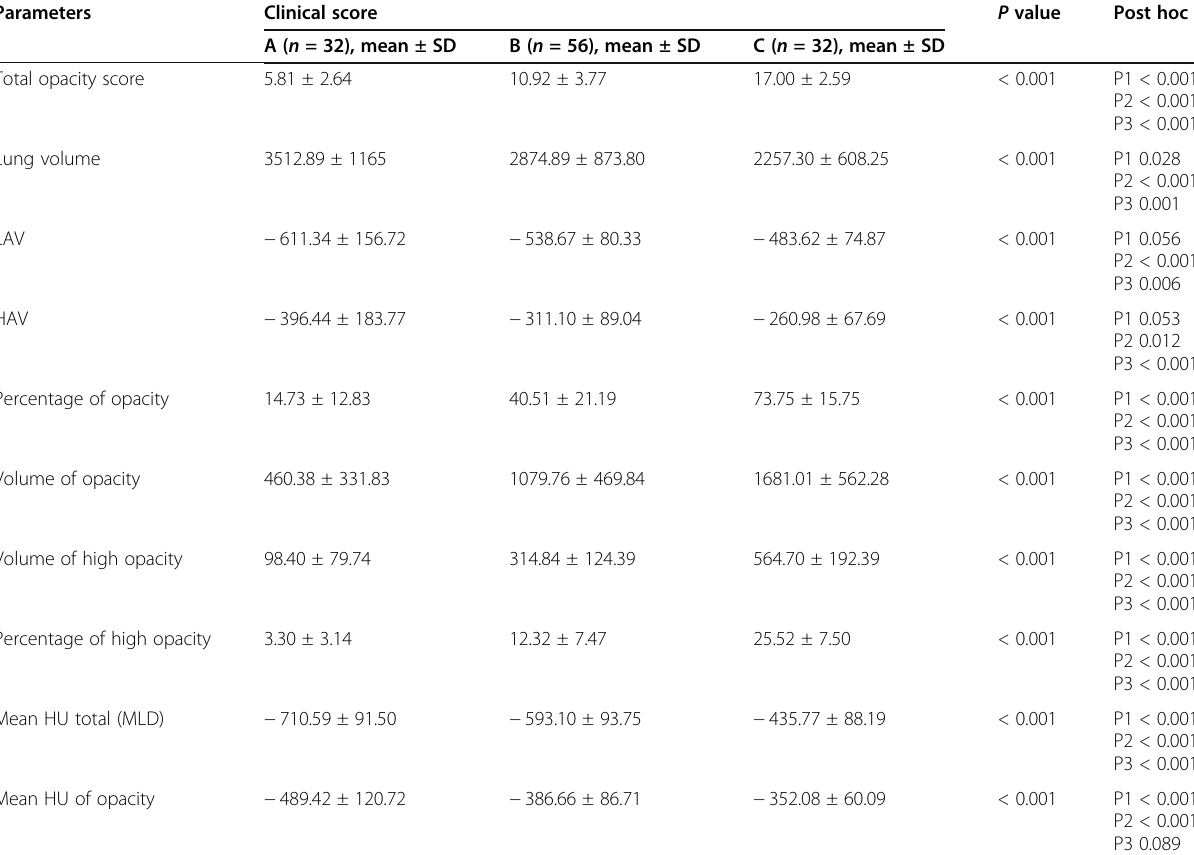
Table 2 Quantitative parameters at different clinical groups